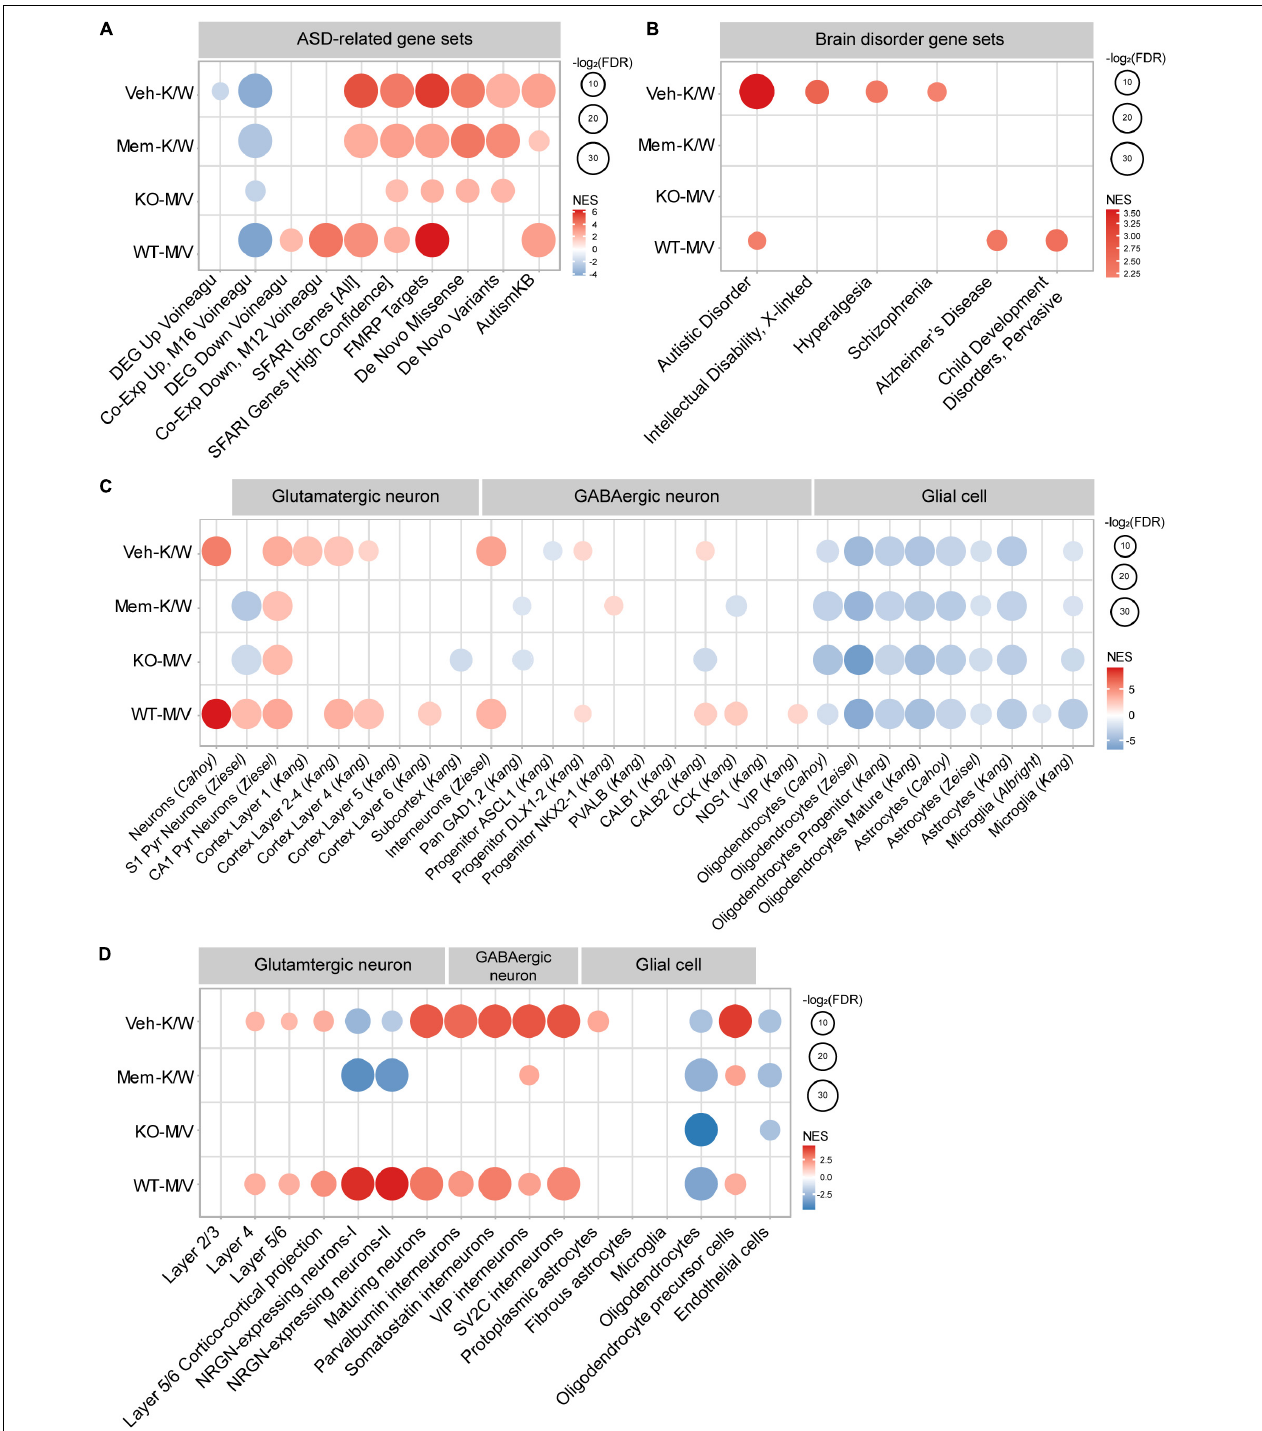
FIGURE 6 | Gene Set Enrichment Analysis of Veh-K/W, Mem-K/W, KO-M/V, and WT-M/V transcripts for ASD- and cell-type–related gene sets. (A,B) GSEA results for four transcript groups (Veh-K/W, Mem-K/W, KO-M/V, and WT-M/V) showing enrichment patterns for ASD-related/risk and brain disorder-related (DisGeNet) gene sets, including ASD-related gene sets that are upregulated in ASD (DEG_Up_Voineagu and Co-Exp_Up_M16_Voineagu) and downregulated in ASD (DEG_Down_Voineagu and Co-Exp_Down_M12_Voineagu) and ASD-risk gene sets that are likely to be downregulated in ASD [SFARI (all) SFARI (high confidence), FMRP targets, De Novo Missense, De Novo Variants, and AutismKB]. ( n = 3 mice for WT-Veh, WT-Mem, KO-Veh, and KO-Mem, FDR < 0.05). (C) GSEA